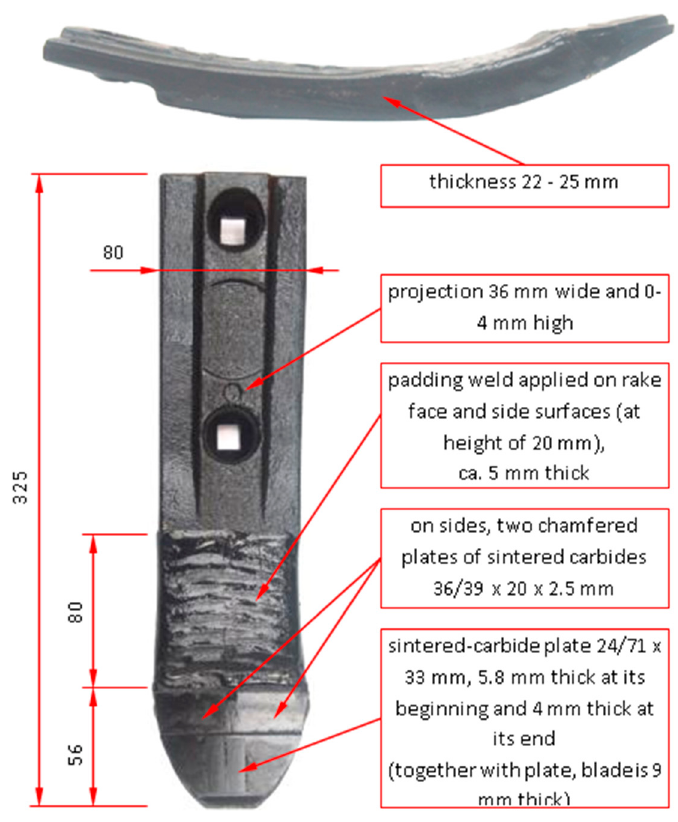
Figure 1. Geometry and structure of the coulters used in this research [24].